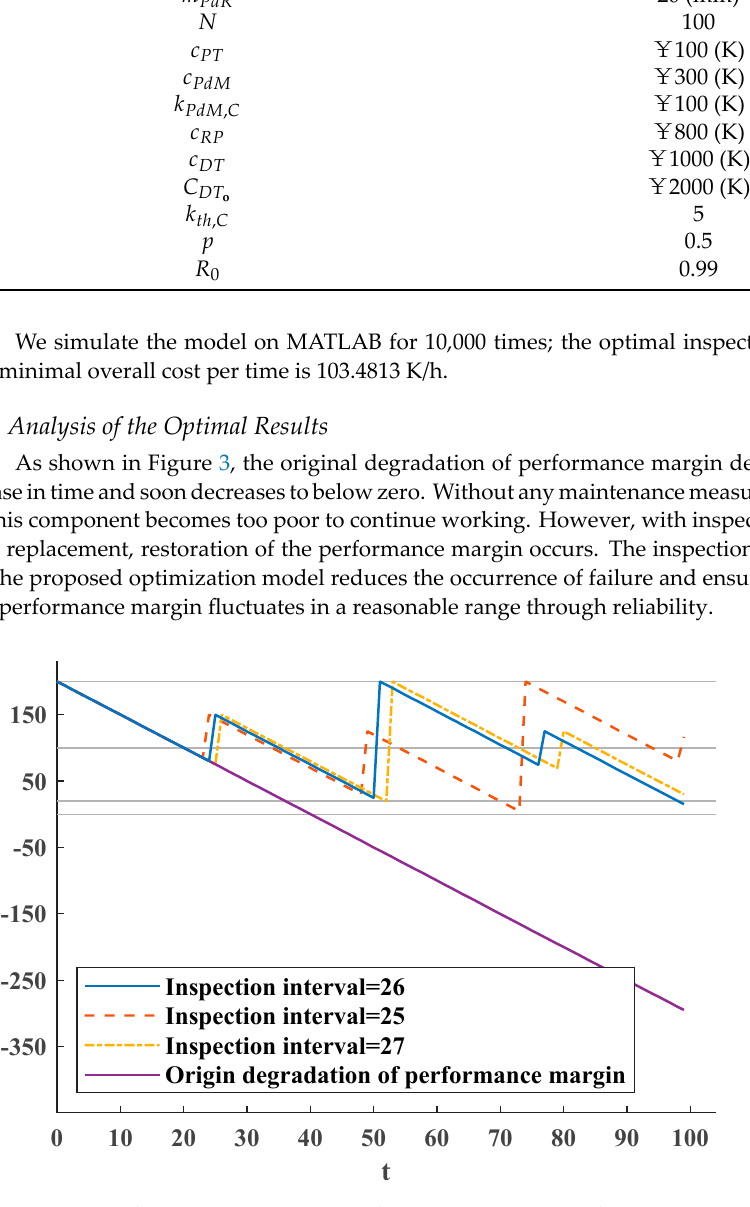
Figure 3. Optimal maintenance process when inspection intervals are 25, 26 and 27.